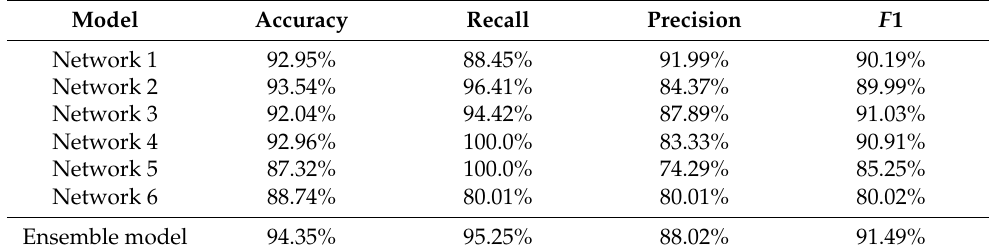
Table 3. Evaluationofthesixmodelsandtheresultoftheircombination(ensemblemodel)forclassification.